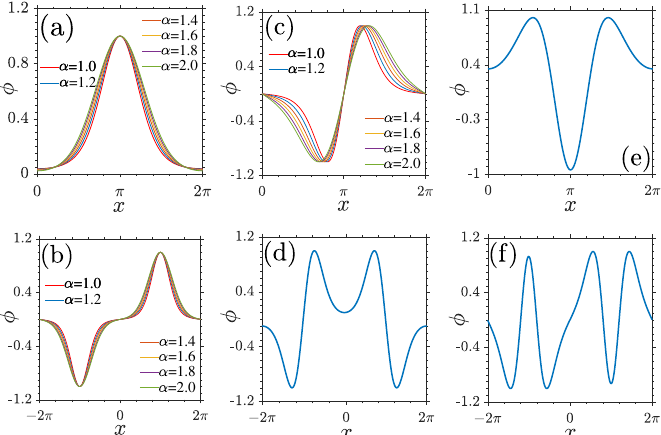
Figure 2. Normalized linear Bloch modes marked inFigure 1c at the centers ( a , c , e ) and the edges ( b , d , f ) of the BZ. α = 1.6 in ( d – f